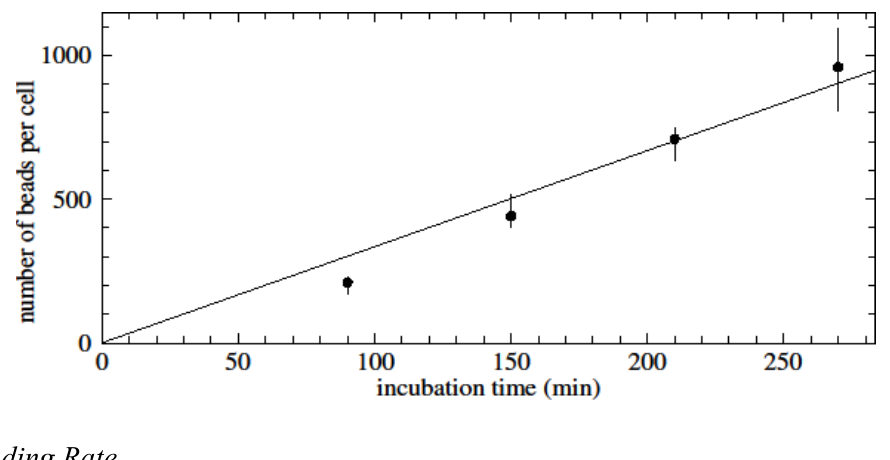
Figure 7. Time-dependent unspecific binding of anti-CD14 conjugated magnetic nanobeads to untouched CD3-positive cells. Concentration of nanobeads: 16 µg/100 µL; concentration of target cells: 10 6 /100